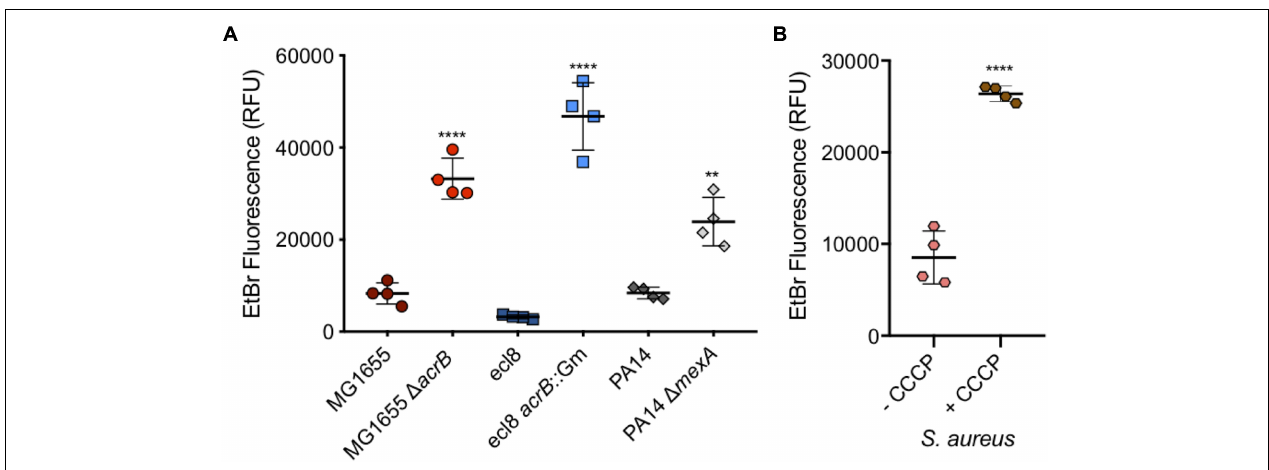
FIGURE 9 | Accumulation of ethidium bromide in WT and efflux mutants of Escherichia coli , Klebsiella pneumonia , and P. aeruginosa , and in Staphylococcus aureus with CCCP. (A) E. coli MG1655 (dark red circles) had an average fluorescence of 8310 RFU and was significantly lower (fourfold) than its (cid:49) acrB (red circles) equivalent at 33233 RFU. Klebsiella pneumoniae ecl8 (dark blue squares) had an average RFU of 3225, 14-fold lower than its acrB ::Gm inactivated strain with a RFU of 46764. P. aeruginosa strain PA14 (gray diamonds) had ethidium bromide fluorescence of 8401 RFU which was significantly lower than the fluorescence for its (cid:49) mexA strain at RFU (threefold difference). (B) S. aureus ethidium bromide accumulation was measured in the absence (pink) and presence (brown) of CCCP. In the presence of CCCP, accumulation was threefold higher ( P < 0.0001). 4 biological replicates for each strain are shown, with a long bar to show the mean and standard error of the mean (SEM) error bars. Statistical tests were unpaired T -tests between individual WT and efflux deficient strain. Results were considered significantly different if p -value ≤ 0.05. ∗∗ and ∗∗∗∗ correspond to P -values shown in Supplementary Table S3 .